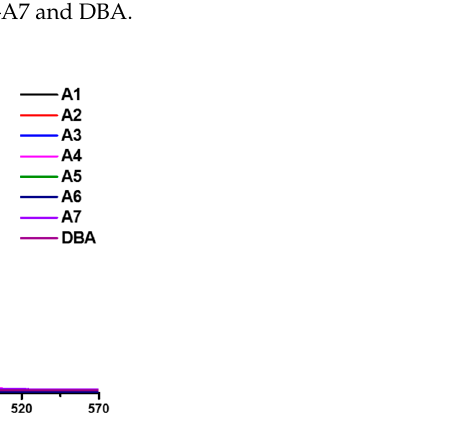
Figure 15. Chemical structures of A1–A7 and DBA.